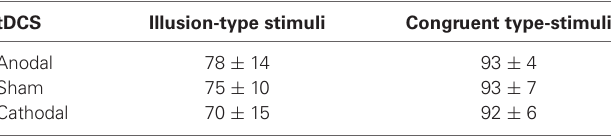
Table 1 | Percentage of correct responses during the STS experiment